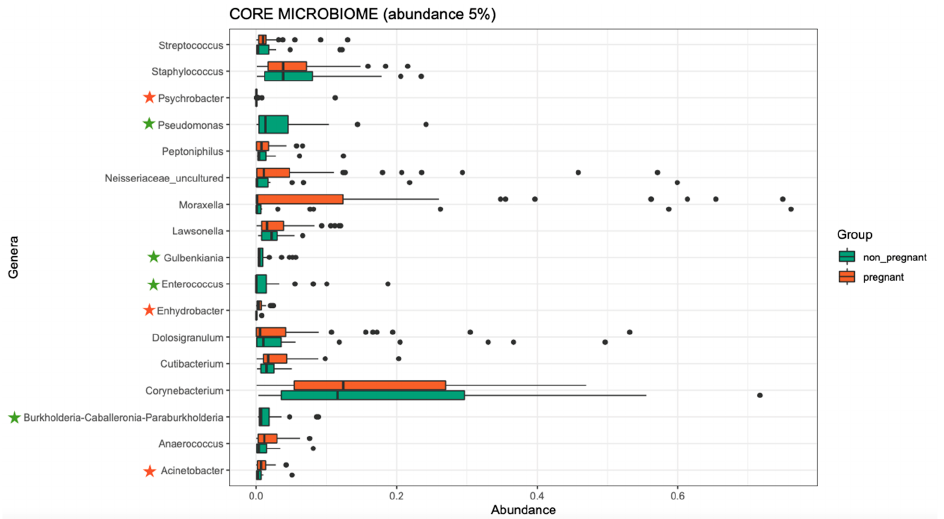
Figure 2. The core microbiome of pregnant women and non-pregnant women groups. Stars indicate the genera that are different between the two groups. Two genera showed higher abundance in the pregnant group, and one was identified only in the pregnant group (orange stars); four genera were identified only in the non-pregnant group (green stars).